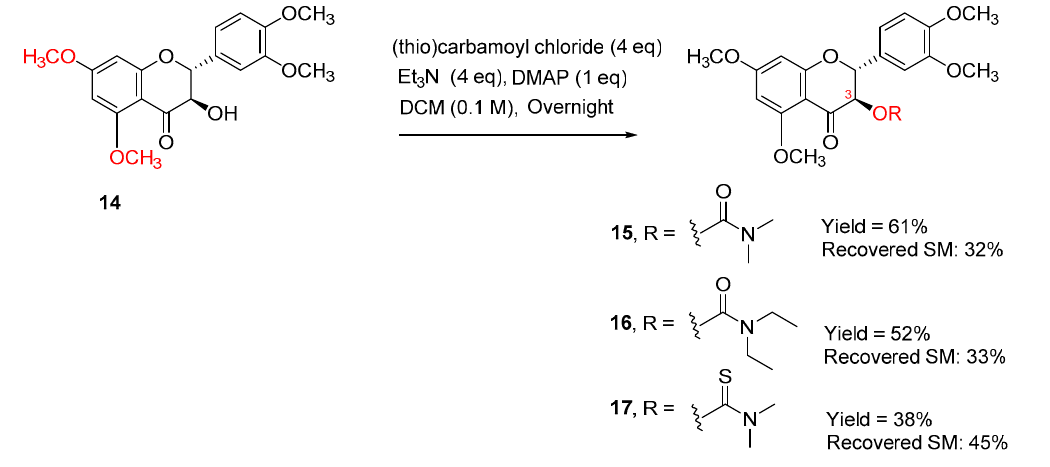
Scheme 4. Synthesis of 3- O